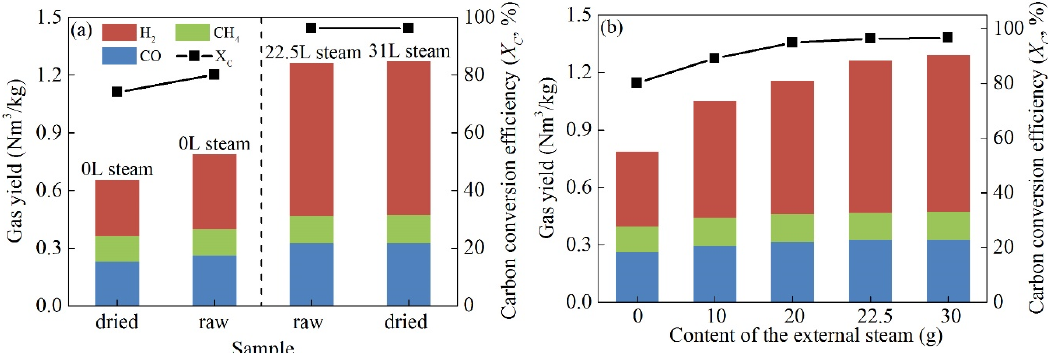
Figure 8. The gas yield and carbon conversion efficiency obtained in the 46:54 mixture fuel of dewatered/raw cyanobacteria: ( a ) comparison between dewatered and raw samples; ( b ) raw sample under different contents of the external steam.